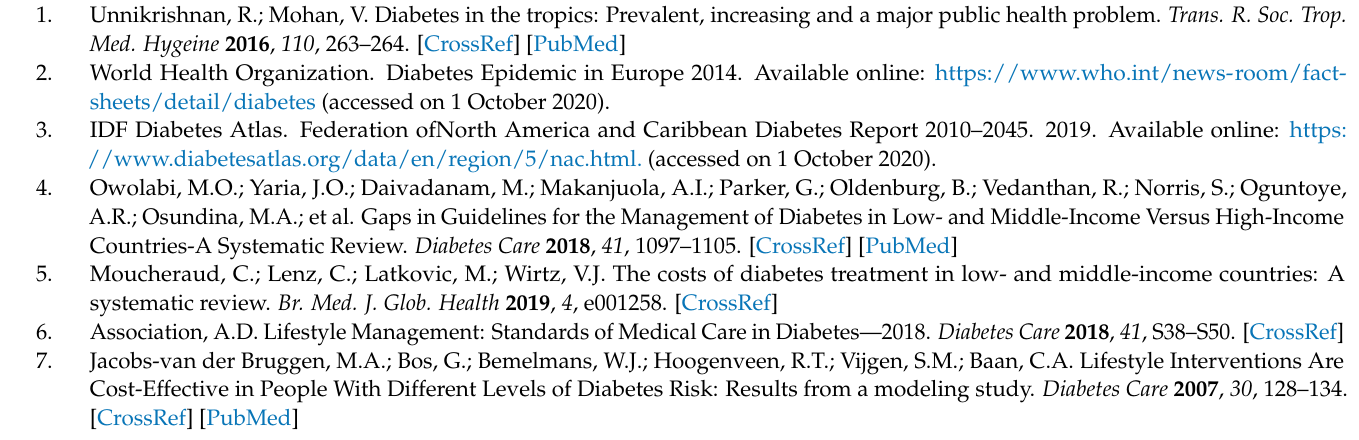
Table S3: Outcome measures reported in included trials, Table S4: EPHPP tool quality assessment rat- ings, Figure S1: Funnel Plots, Table S5: GRADE quality of evidence, Table S6: PRISMA 2020